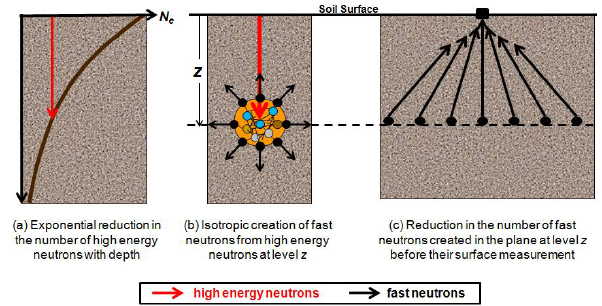
Fig. 1. The three physical processes represented in the COSMIC model that are assumed to control the above ground fast neutron count rate.